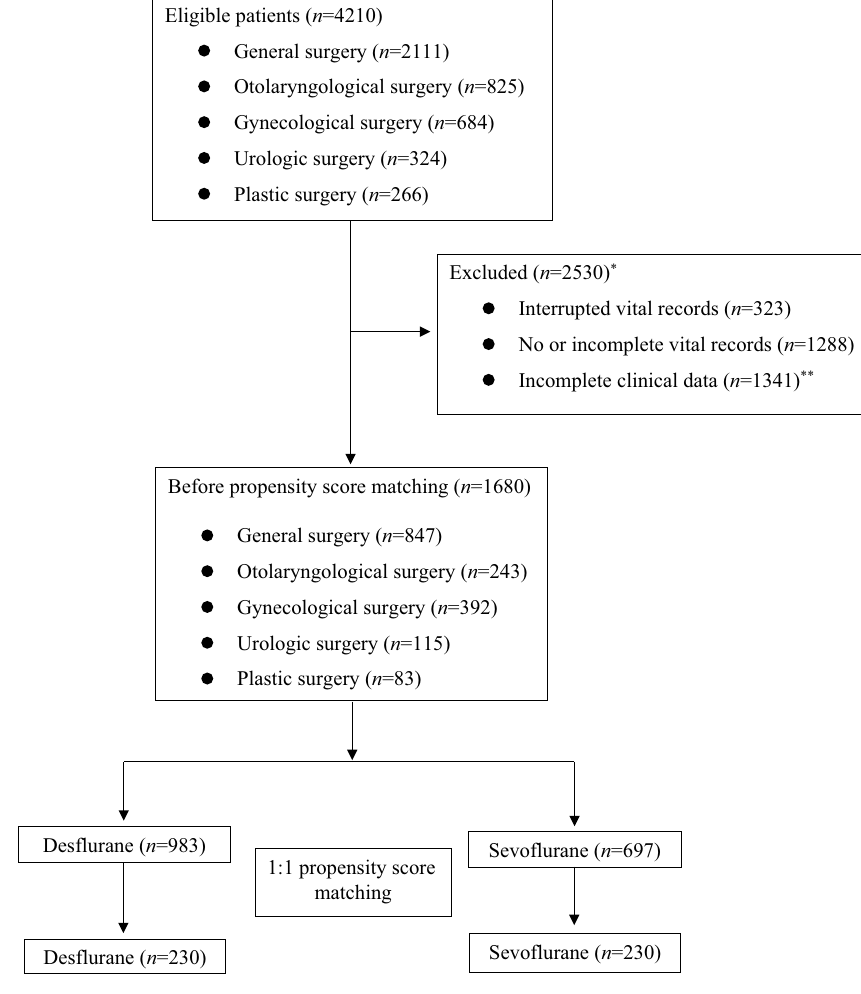
Figure 1. Patient flow chart. * Includes duplicated reasons. ** Mainly due to intraoperative remifentanil dose ( n =